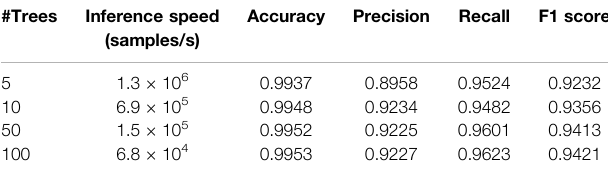
TABLE 6 | Results from different experiments using Random Forest Classi fi er without engineered features. #Trees